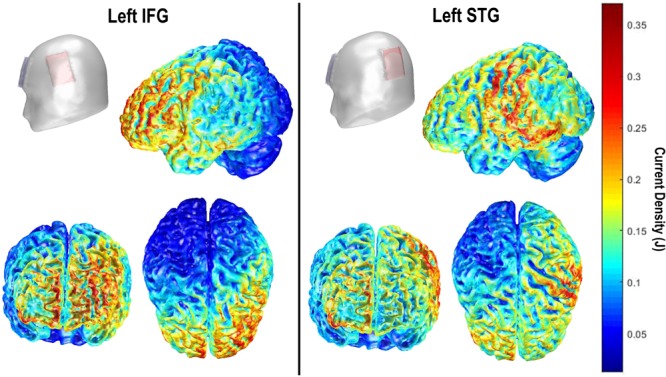
COMETS2 (Lee et al., 2017) current density (J) models for left IFG (Left) and left STG montages (Right).